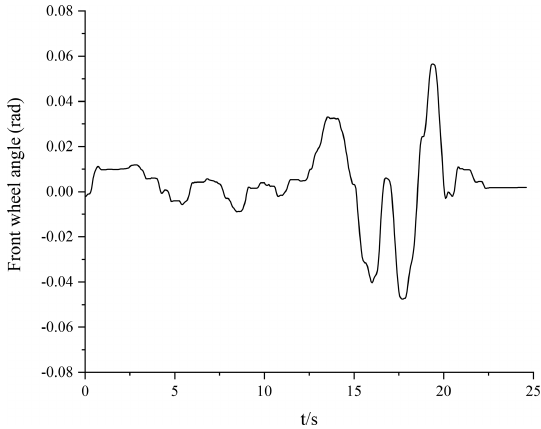
Figure 14. Front-wheel